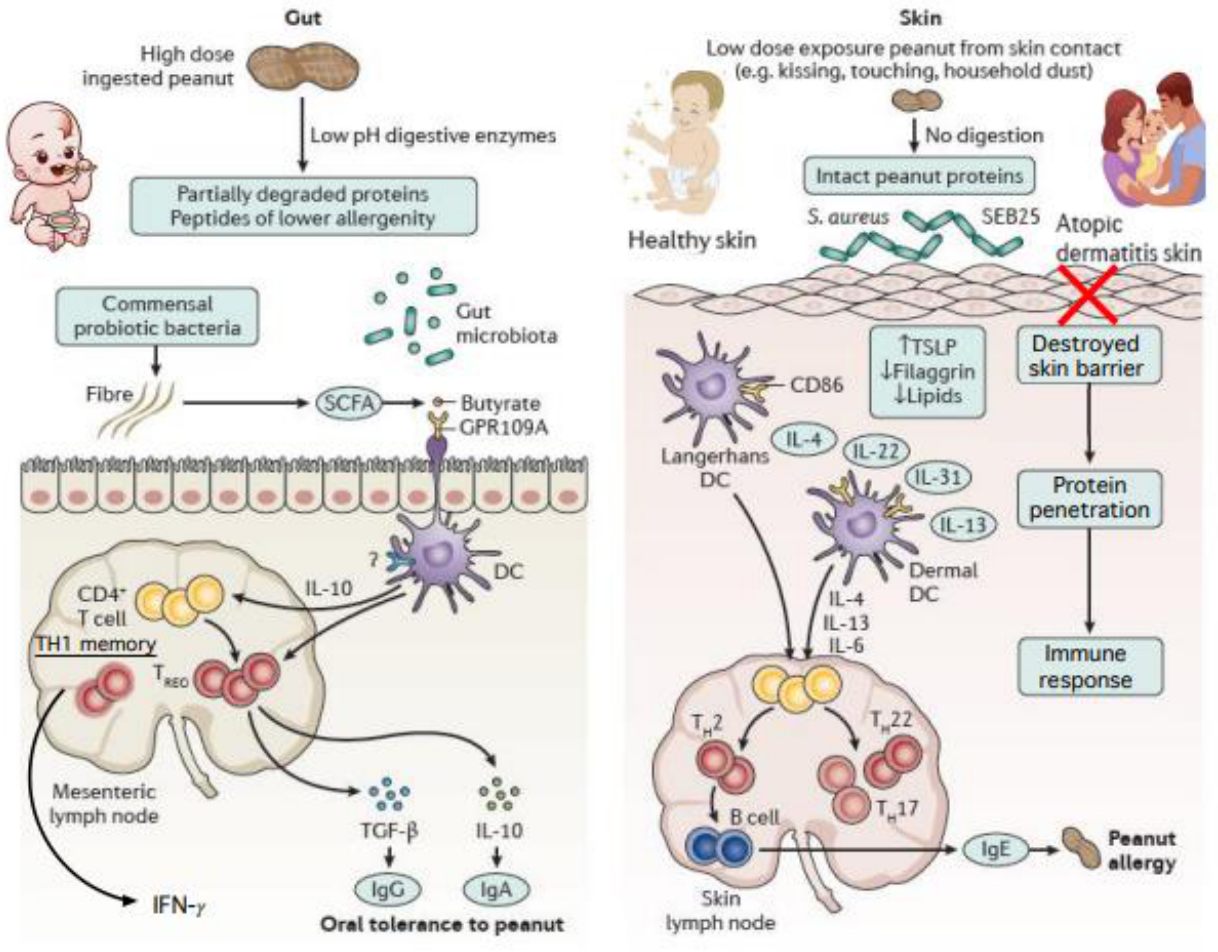
Figure 1. Exposure to foods via ingestion results in oral tolerance in contrast to cutaneous or inhalational exposures that promote IgE-sensitization [11]. Table 1. A summary of international consensus guidelines on early introduction of allergenic foods.